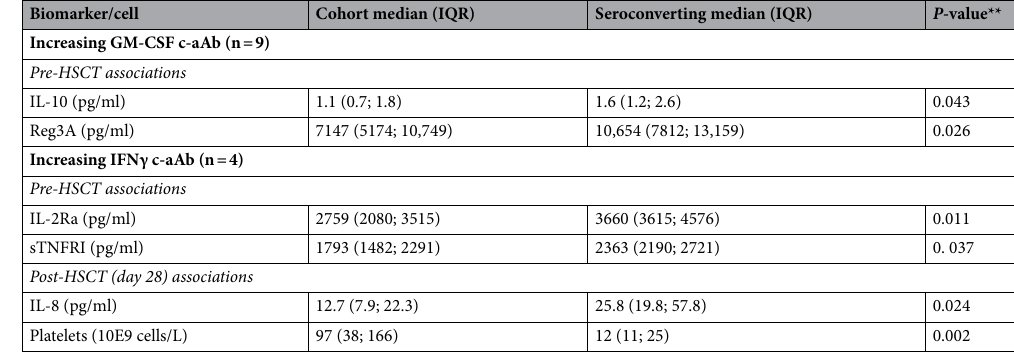
Table 3. “Seroconverting”* cases with increasing GM-CSF and IFNγ c-aAbs over the duration of HSCT vs cells and biomarkers. *“Seroconversion” defined as having a maximum observed c-aAb MFI > 90th percentile and a (maximum c-aAb MFI/minimum c-aAb MFI) factor difference of ≥ 5. **Mann–Whitney U -tests, concentration comparison between c-aAb-increasing seroconverting individuals and non-seroconverting individuals pre or post HSCT, P -value